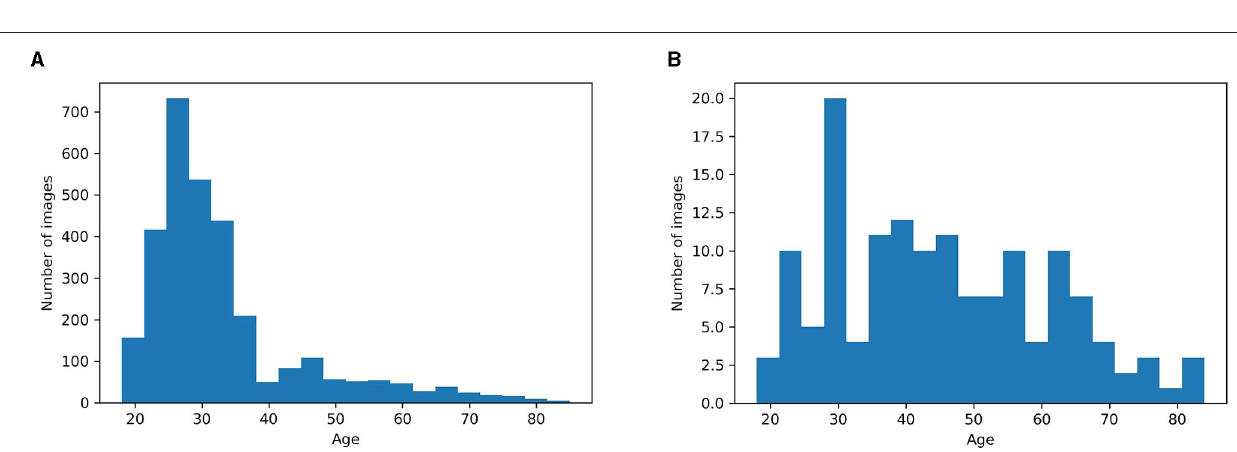
images from 110 subjects, with 10 randomly selected